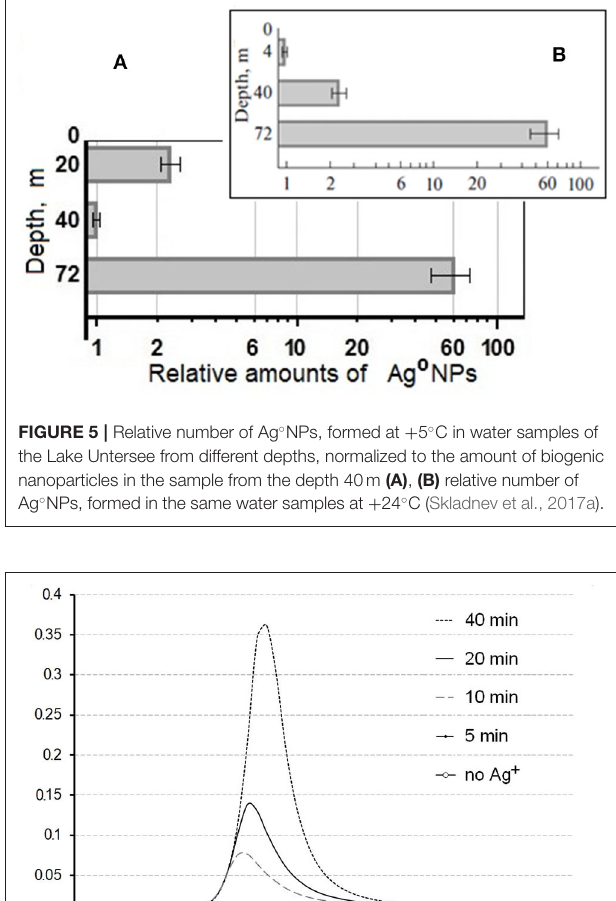
( Figure 6 ). Several models of miniature spectrometers